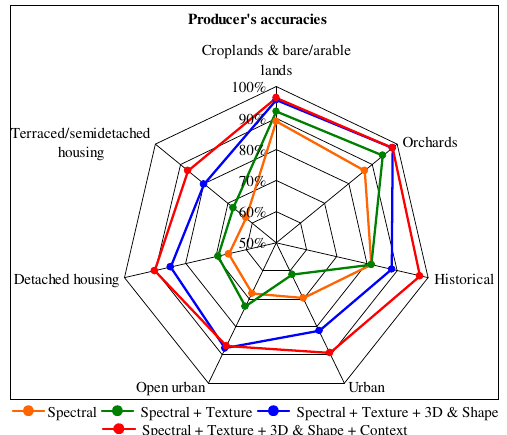
Figure 4. Producer’s accuracies as feature groups are